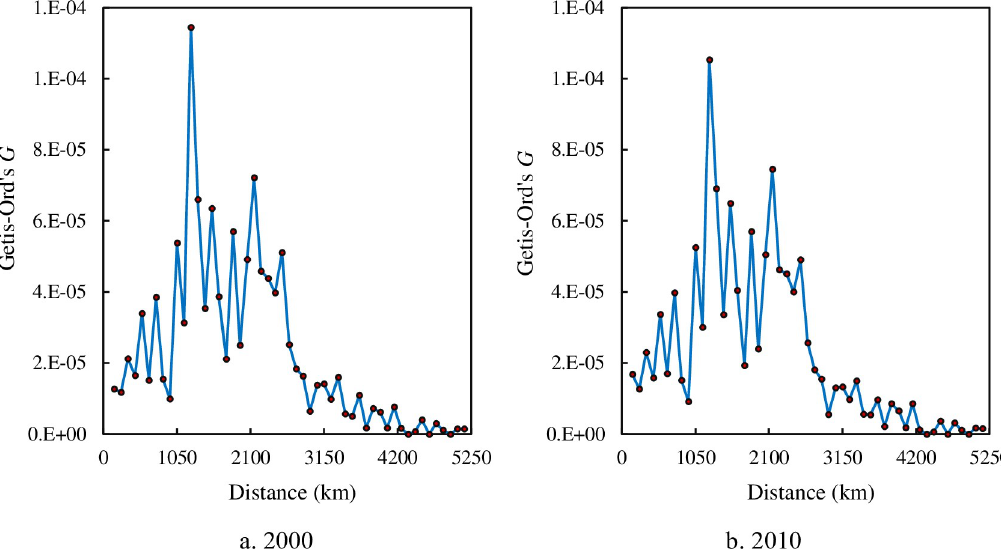
Fig 11. The curves of Getis-Ord’s G based on correlation density for the main cities of China. ( Note : Inside the scaling ranges of spatial correlation dimension, the curves of Getis-Ord’s G fluctuate significantly. From 2000 to 2010, the curve shapes have slight